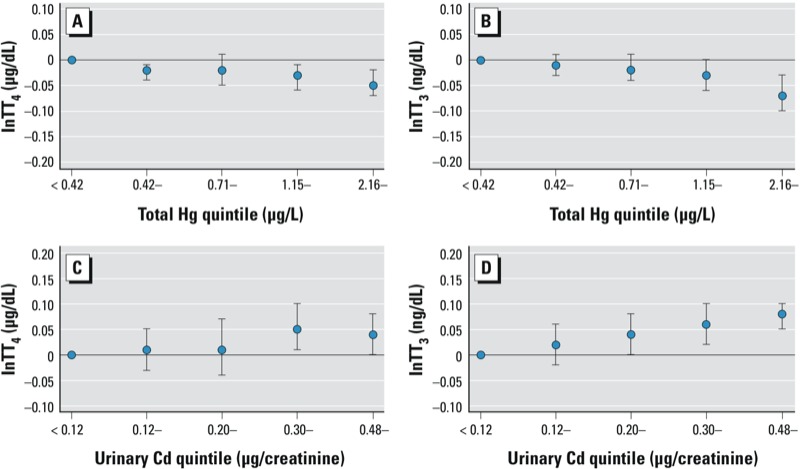
Estimated thyroid hormone levels according to natural log blood total Hg or urinary Cd exposure quintiles in adults, NHANES 2007–2008. (A) TT4 by blood total Hg quintiles, (B) TT3 by blood total Hg quintiles, (C) TT4 by urinary Cd quintiles, (D) TT3 by urinary Cd quintiles.